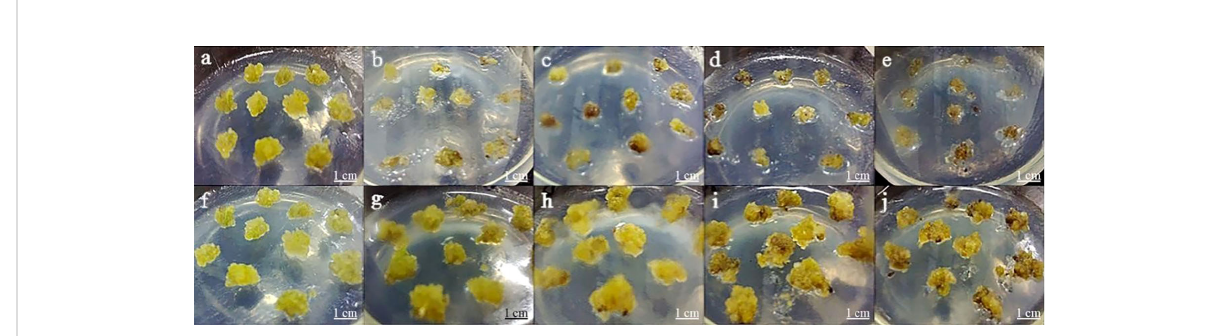
FIGURE 4 Antibiotic sensitivity assay of P. lacti fl ora callus. (A-E) kanamycin concentrations were 0, 75, 100, 125 and 150 mg·L -1 , respectively. (F-J) cefotaxime concentrations were 0, 100, 200, 300, and 400 mg·L -1 ,